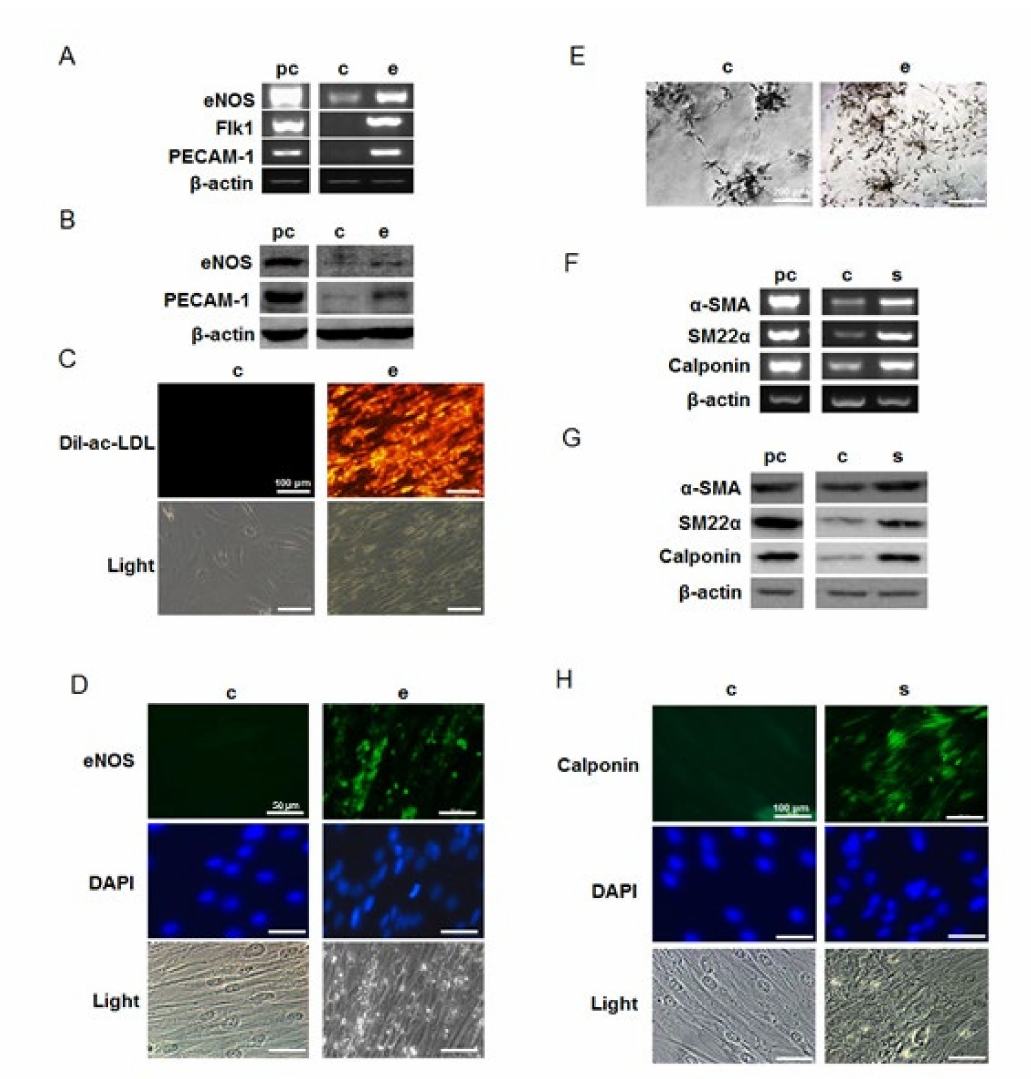
Figure 2. Induction of endothelial and smooth muscle cell markers when hMSCs were grown in endothelial and smooth muscle cell di ff erentiation media. Endothelial di ff erentiated cells showed up-regulation of endothelial cell markers eNOS, flk-1 and PECAM-1 by RT-PCR ( A ) and Western blot ( B ); immunochemical analysis showed di ff erentiated cells positively expressed eNOS ( D ). Di ff erentiated cells could uptake DiI-ac-LDL ( C ) and form more tubes in Matrigel better than un-di ff erentiated cells ( E ); up-regulations of smooth muscle cell specific marker α -SMA, SM22 α and calponin were found in smooth muscle di ff erentiated cells in both gene ( F ) and protein ( G ) levels. Di ff erentiated cells showed positive immunofluorescent staining for calponin ( H ); pc, positive control; c, un-di ff erentiated cells; e, endothelial di ff erentiated cells; s, smooth muscle di ff erentiated cells. 2.3. P2 Receptor Expression during Endothelial and Smooth Muscle Cell Di ff erentiation RT-PCR revealed that P2X5, P2Y1, P2Y2, P2Y4, P2Y11 and P2Y14 were